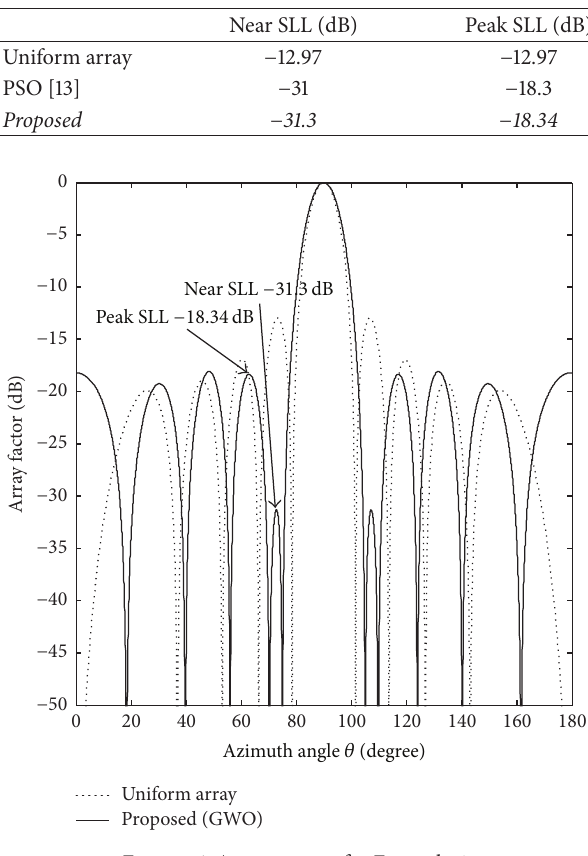
Figure 6: Array pattern for Example